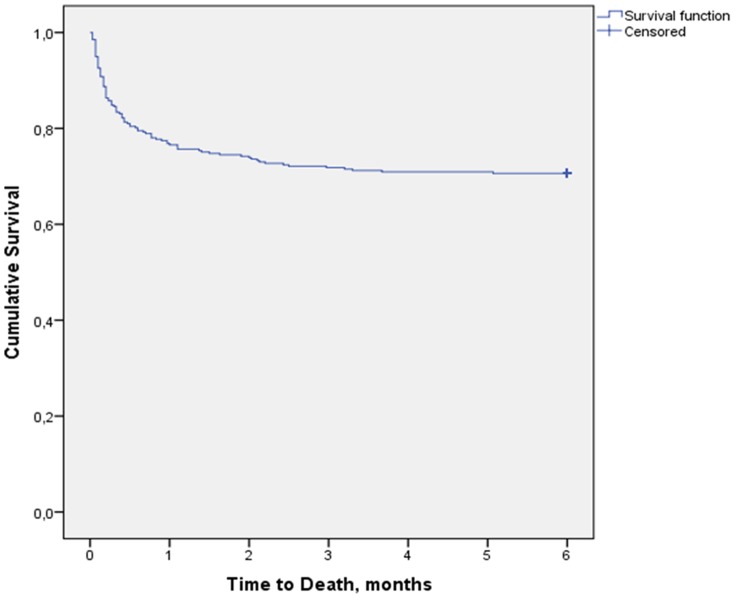
Kaplan-Meier survival curve of TB/HIV co-infected patients on TB treatment (N = 337).